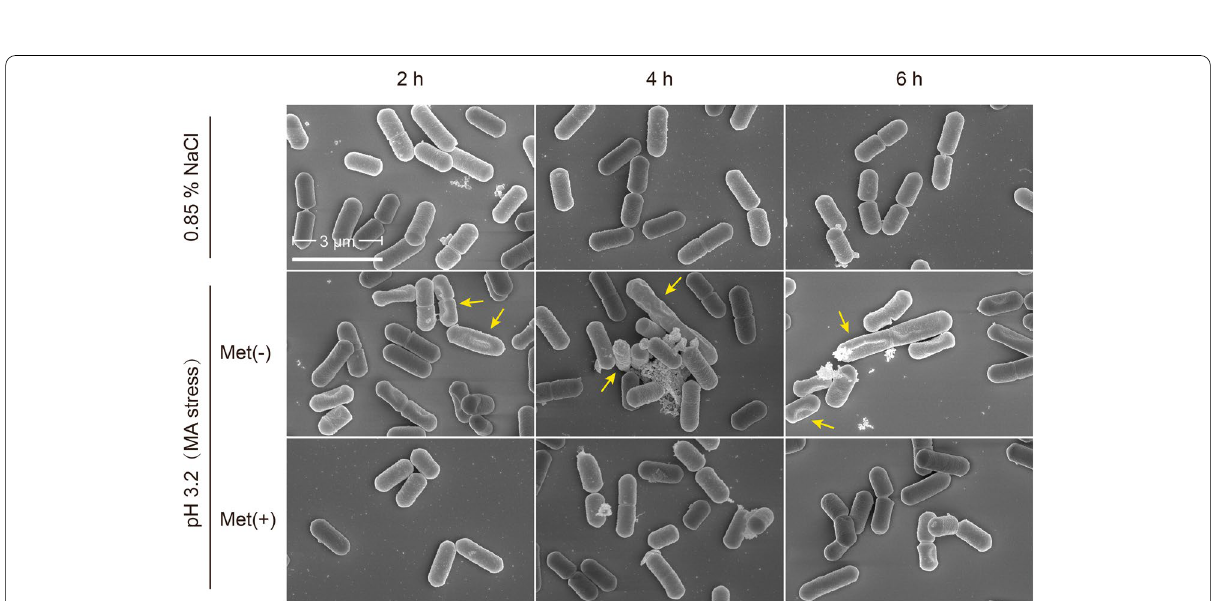
Fig. 2 Scanning electron microscopy of L. plantarum XJ25 cells under acid stress. Met( Scale bar represents 3